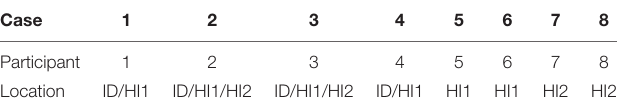
TABLE 3 | Respiration rate cases (Hill, 2019).